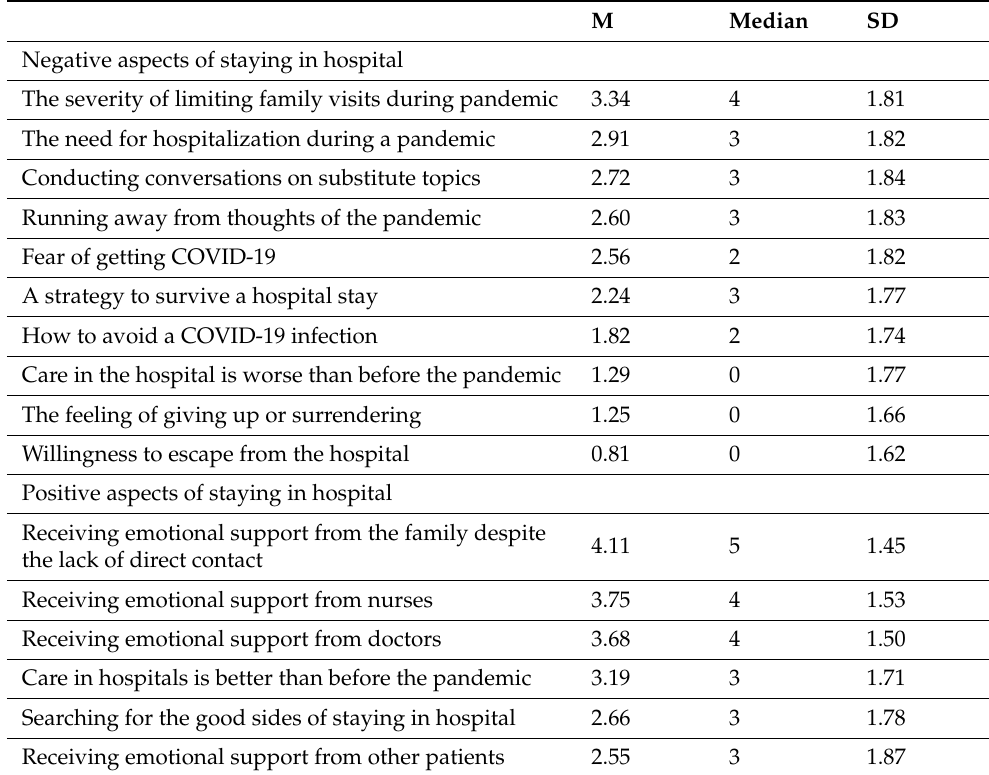
Table 1. Negative and positive aspects of a hospital stay, as assessed by the respondents. M Median